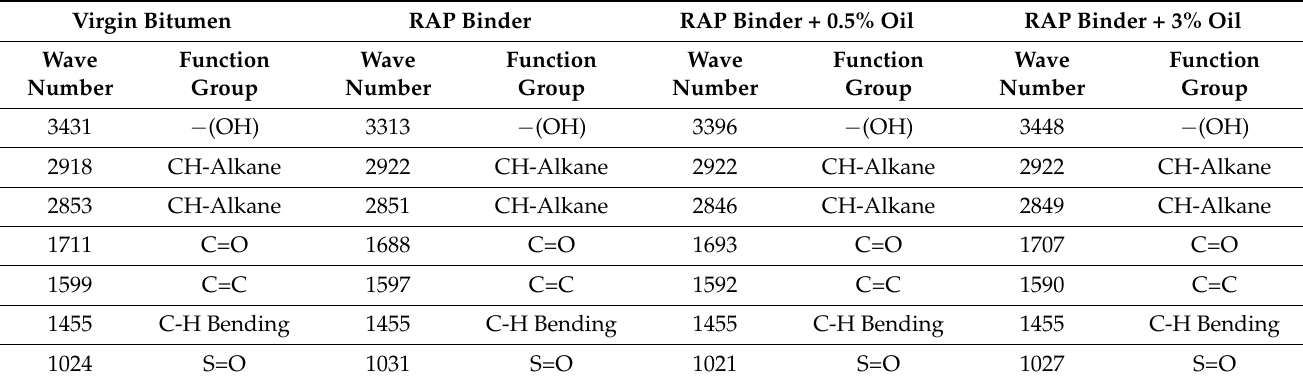
Figure 10. FTIR for virgin bitumen, aged bitumen, and rejuvenated bitumen. Table 5. Fourier transform infrared spectroscopy functional groups.